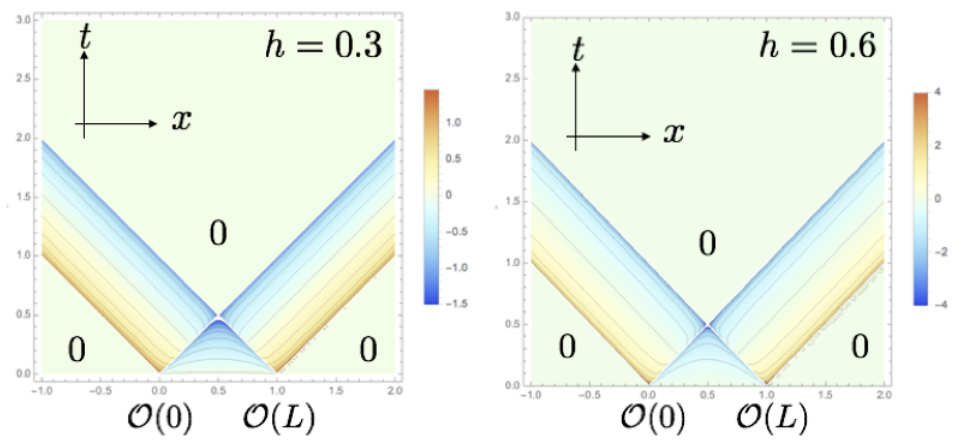
Figure 12 . Entanglement R(cid:19)enyi entropy (cid:1) S 2 of semi in(cid:12)nite half line divided by coupling g . A Value of R(cid:19)enyi entropy depends on the location of the left edge of the half line, which is speci(cid:12)ed by the coordinate ( t; x ). When x > t + L or x + t < 0, (cid:1) S 2 must be zero from causality. Left (cid:12)gure A is for h = 0 : 3 and right one is for h = 0 : 6. In all case one can observe that R(cid:19)enyi entropy behaves in similar way as that of entanglement